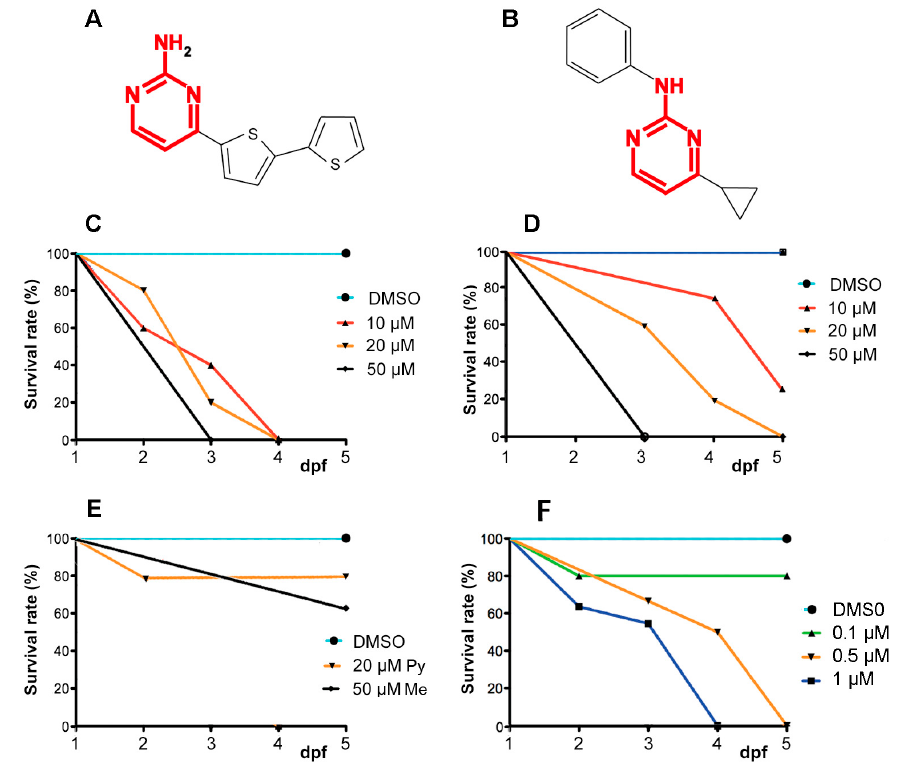
Figure 1. Effects of pyrimidine-containing pesticides on survival of zebrafish larvae. ( A , B ) Formulas of the compounds A6 and cyprodinyl, respectively. The pyrimidine moiety has been highlighted in red; ( C , D ) Survival curves at 2–5 days post-fertilization (dpf) of wild-type embryos exposed at 1 dpf to various concentration of A6 ( C ) and cyprodinyl ( D ); ( E ) Survival curves for pyrimethanyl and mepanipyrim, survival was 100% at all concentrations except 20 µ M pyrimethanyl and 50 µ M mepanipyrim; ( F ) Survival curves for very low concentrations of A6. Each point represents the pooled data from two independent experiments ( n = 10–20 larvae). Differences between the survival curves in panels ( D , F ) are statistically significant (non parametric Mantel-Cox log-rank test, p = 0.00119 for ( D ) and p = 0.048 for ( F )).